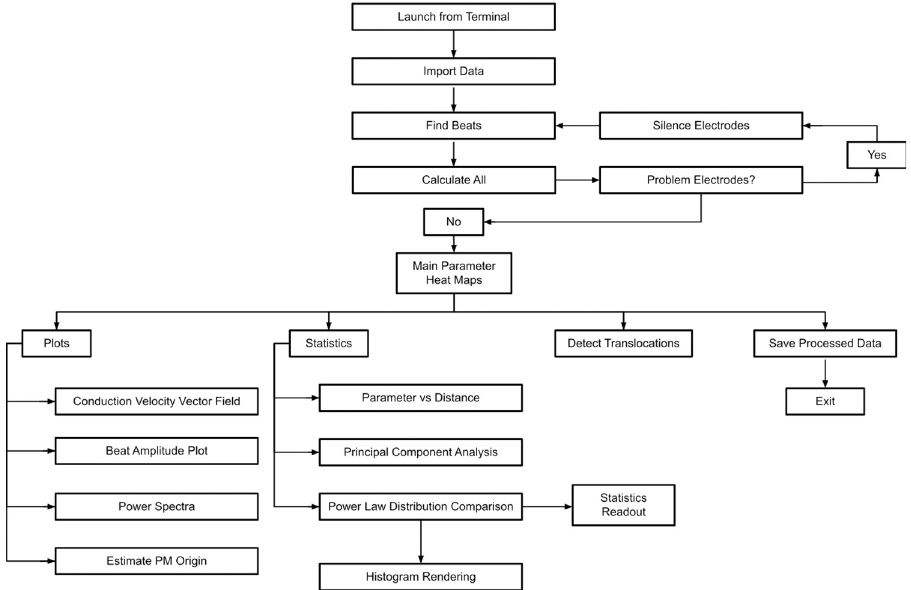
Fig 2. Operational flowchart for using Cardio PyMEA. This flowchart illustrates how Cardio PyMEA can be operated in order to analyze cardiomyocyte MEA